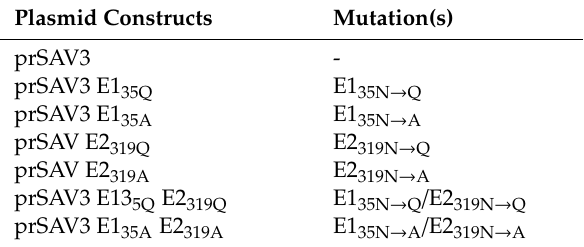
Table 1. Expression